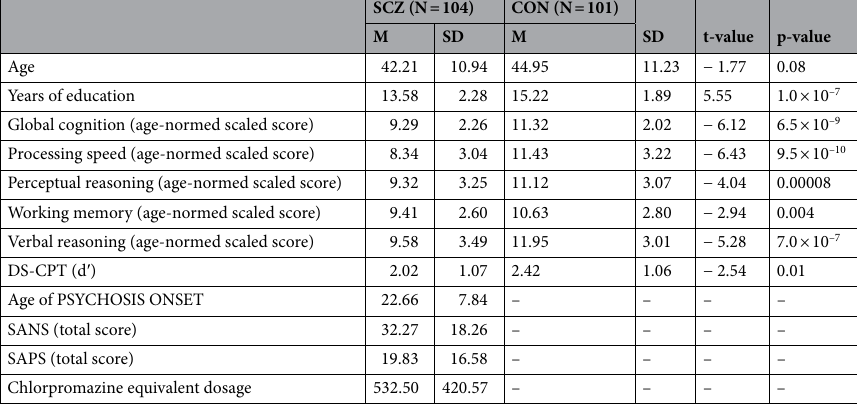
Table 1. Demographics. SCZ (Males = 75; Females = 29) and CON (Males = 60; Females = 41) did not statistically differ on the basis of gender (Χ 2 = 3.14; p = 0.08). SCZ Schizophrenia, CON Controls, DS-CPT Degraded-Stimulus Continuous Performance Test, d ′ D-prime, SANS Scale for the Assessment of Negative Symptoms, SAPS Scale for the Assessment of Positive